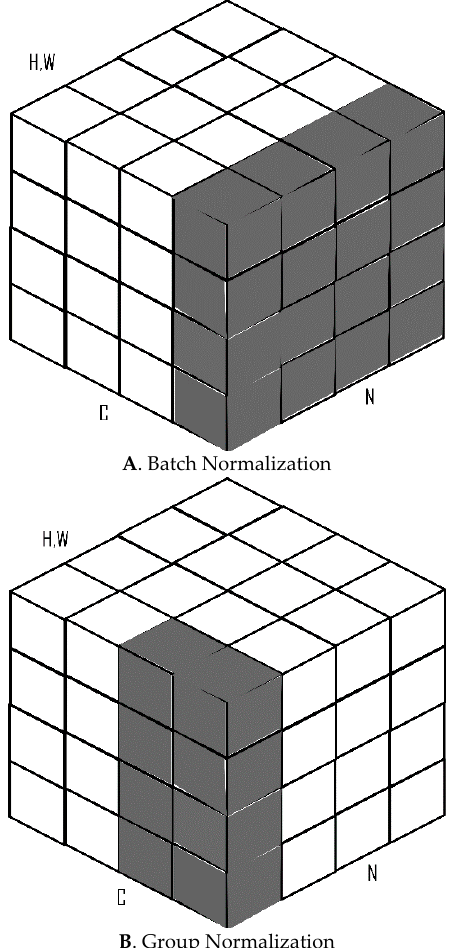
Figure 3. Difference between BN ( A ) and GN ( B ) as in a feature map tensor with the height and width dimensions (H, W), C as the channel axis and N as the batch axis.